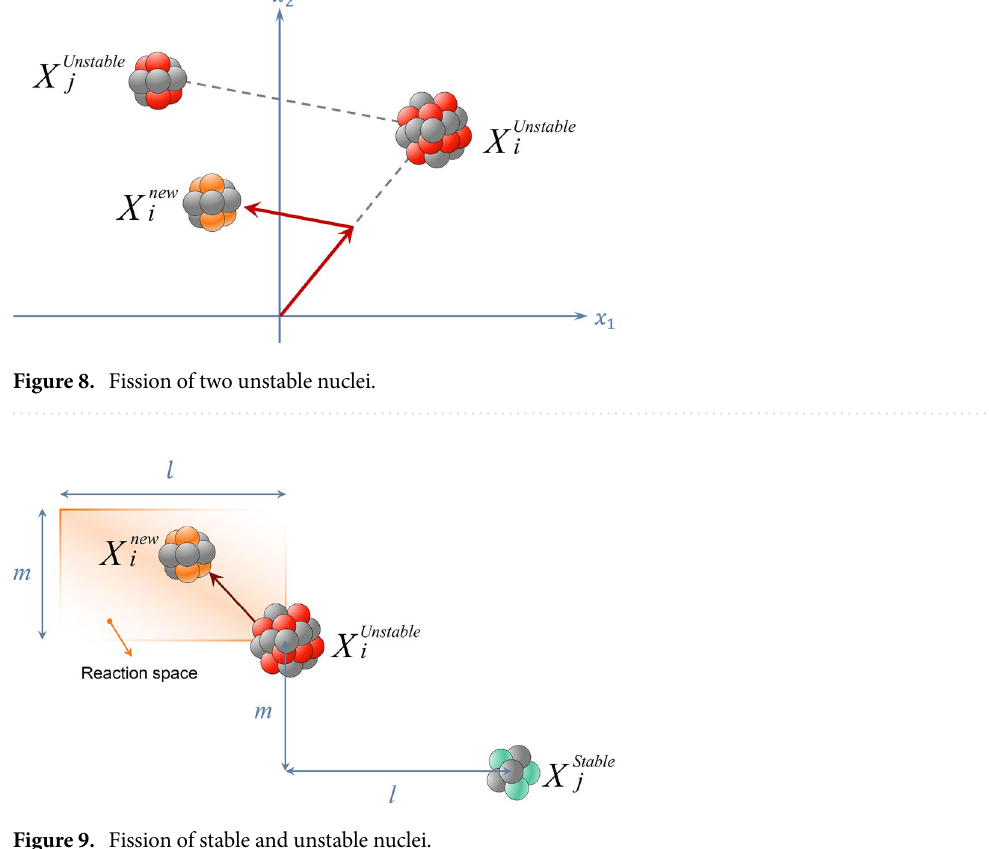
Figure 9. Fission of stable and unstable